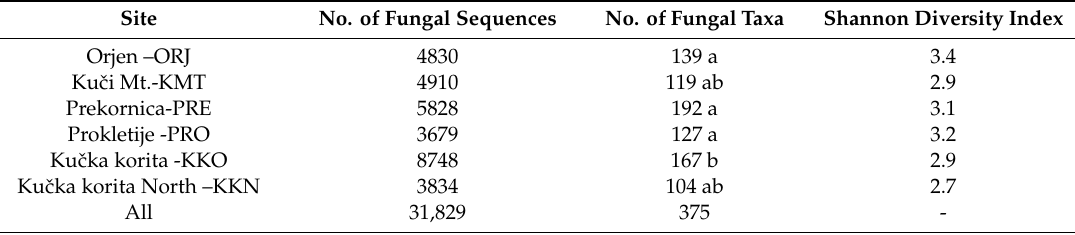
Table 2. Generated high-quality ITS2 rDNA fungal sequences and detected diversity of fungal taxa at di ff erent sampling sites of Pinus heldreichii . Within the column No. of Fungal Taxa , values followed by the same letter in chi-square test do not di ff er significantly at p >